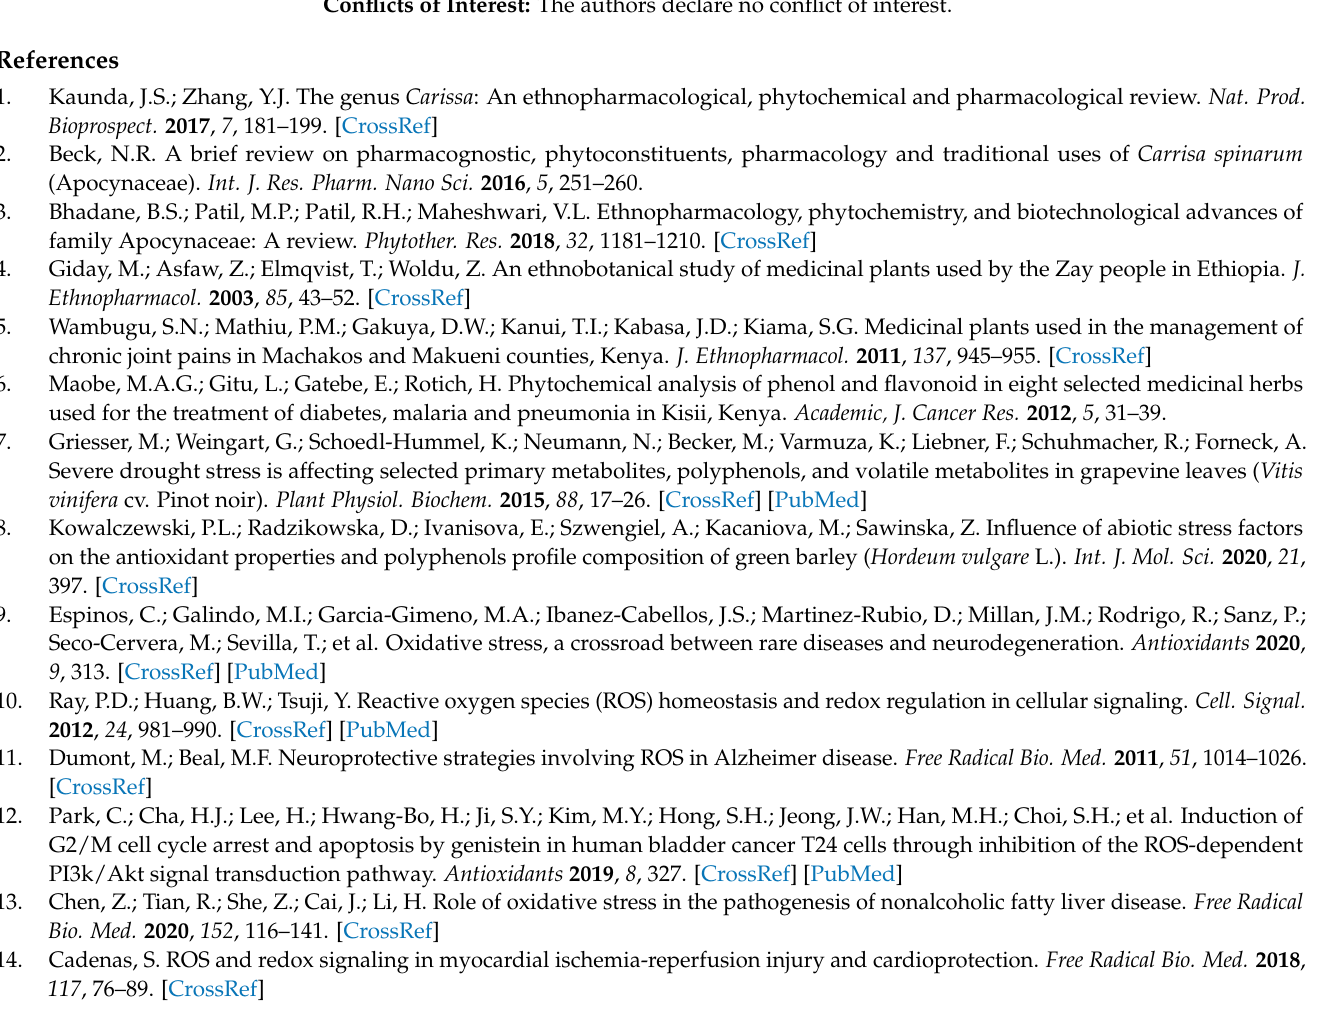
ESI-MS spectrum of 5 , Figure S3: 1 H NMR (600 MHz, CD 3 OD) spectrum of 5 , Figure S4: 13 C NMR (125 MHz, CD 3 OD) spectrum of 5 , Figure S5: DEPT 135 (125 MHz, CD 3 OD) spectrum of 5 , Figure S6: HSQC spectrum of 5 in CD 3 OD, Figure S7: 1 H- 1 H COSY spectrum of 5 in CD 3 OD, Figure S8: HMBC spectrum of 5 in CD 3 OD, Figure S9: NOESY spectrum of 5 in CD 3